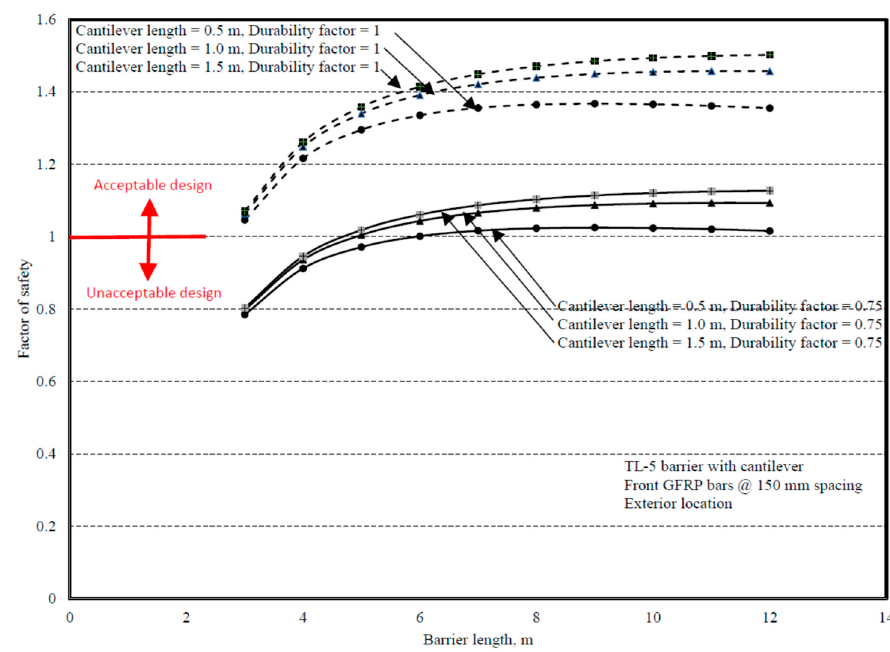
Figure 31. Design factors of safety for TL-5 barrier in Figure 1b at an interior location.